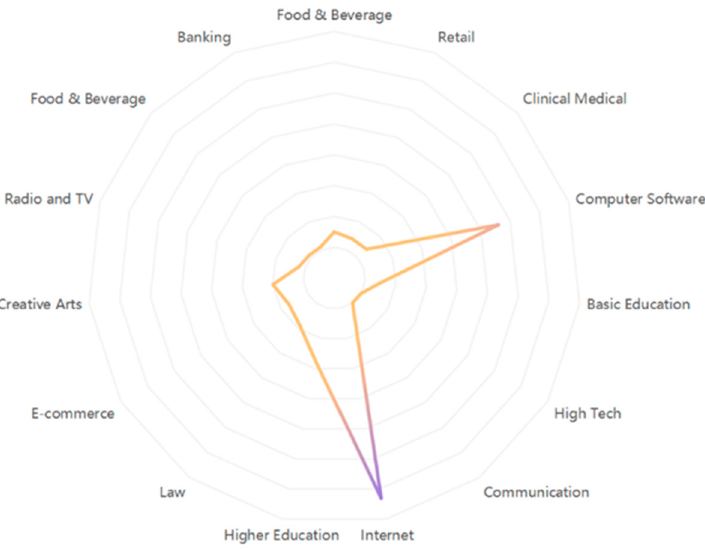
Figure 5. The overall industry characteristics of users on the topic of food safety.